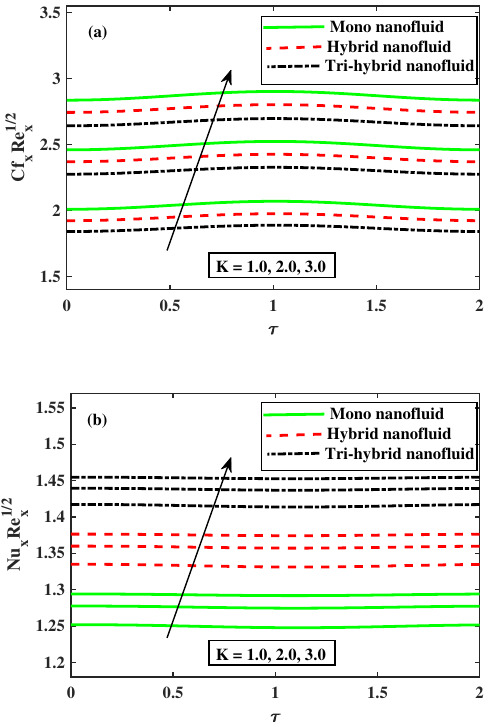
Figure 8. ( a ) Fluctuation of K on Cf x Re 1/2 x ; ( b ) Fluctuation of K on Nu x Re 1/2 x